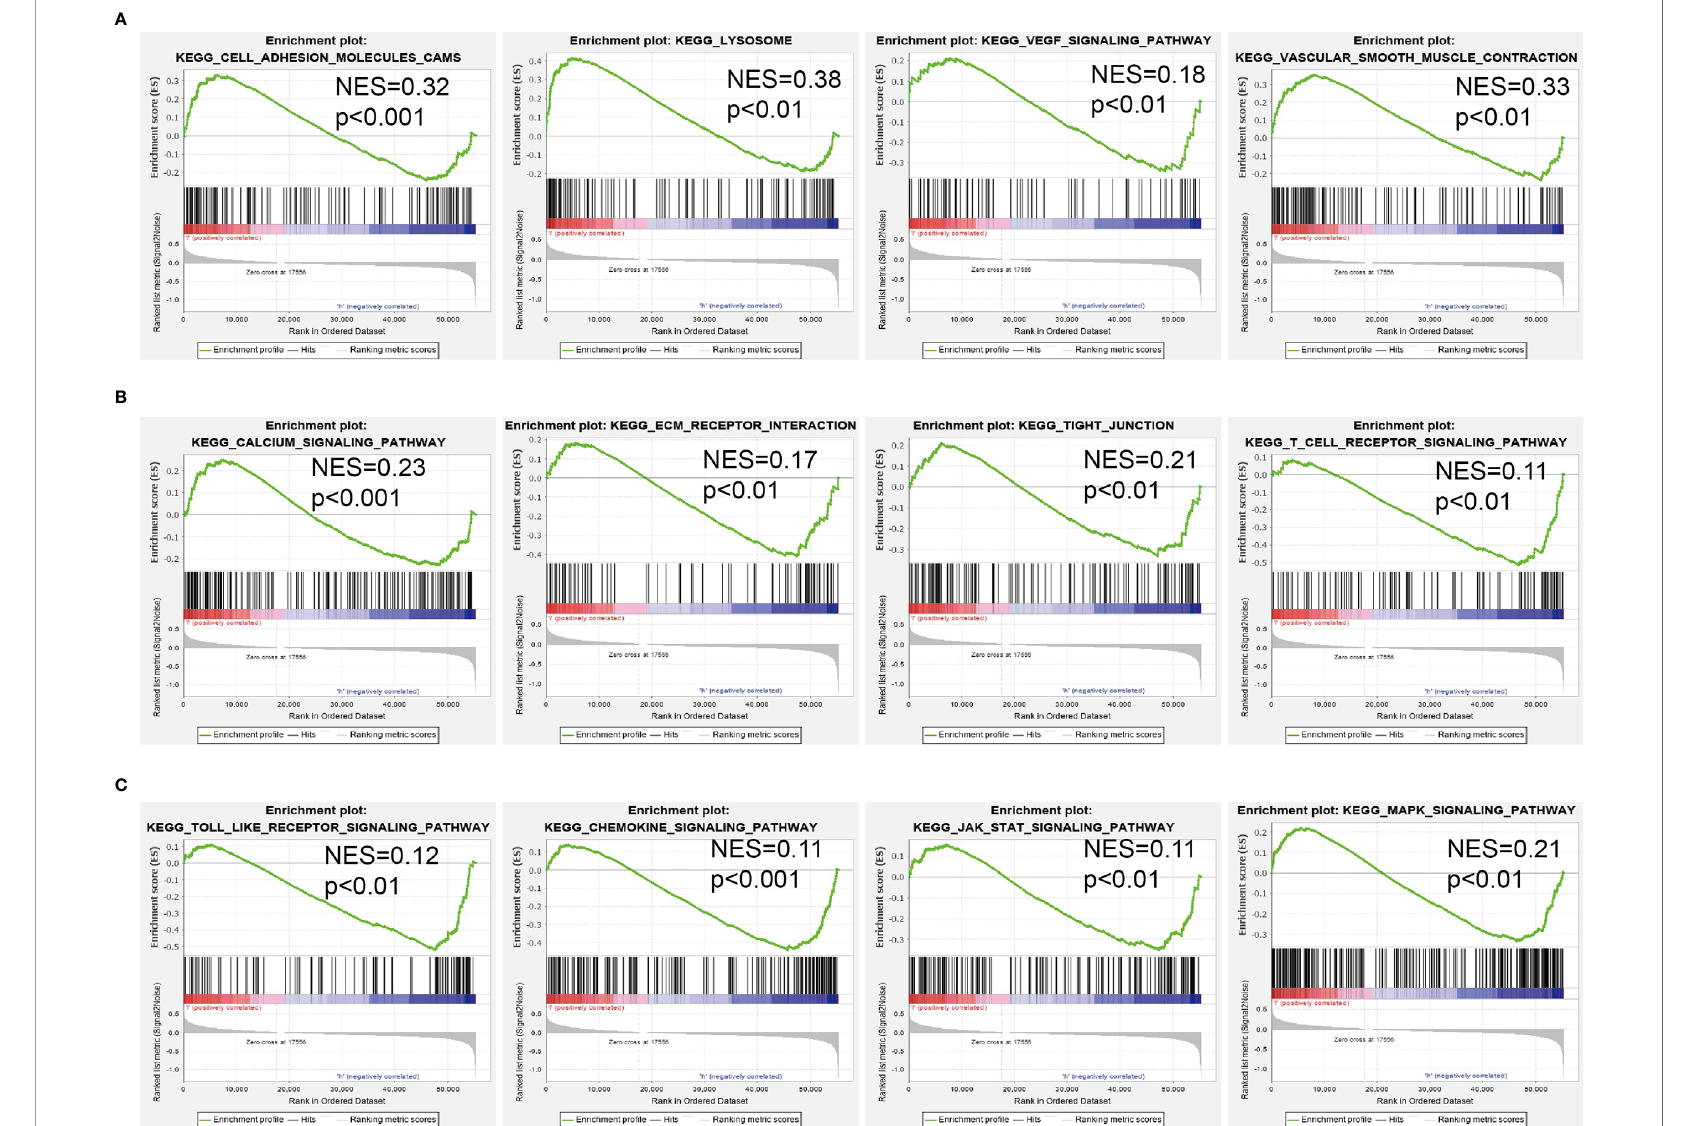
FIGURE 6 | GSEA Identi fi cation of AC099850.3 related signaling pathways. (A – C) Identi fi cation of AC099850.3-related signaling pathways by GSEA